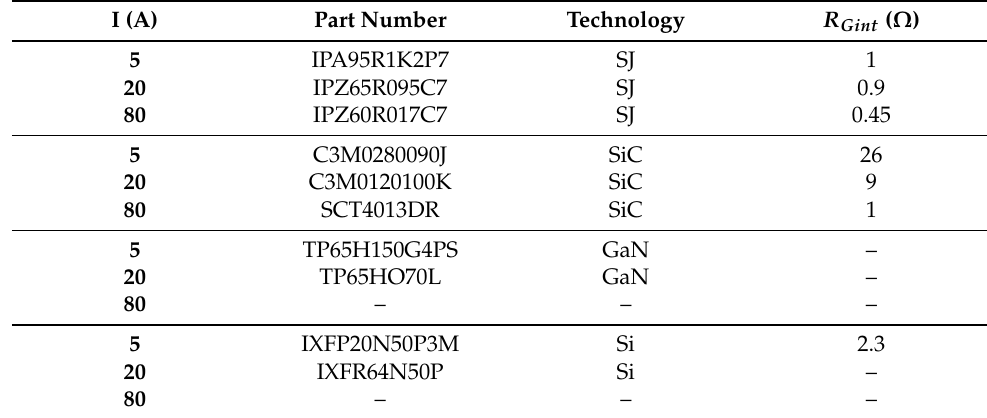
Figure 8. Switching losses evaluation: ( a ) 5 A, ( b ) 20 A and ( c ) 80 A. Table 7. Internal gate resistance for selected